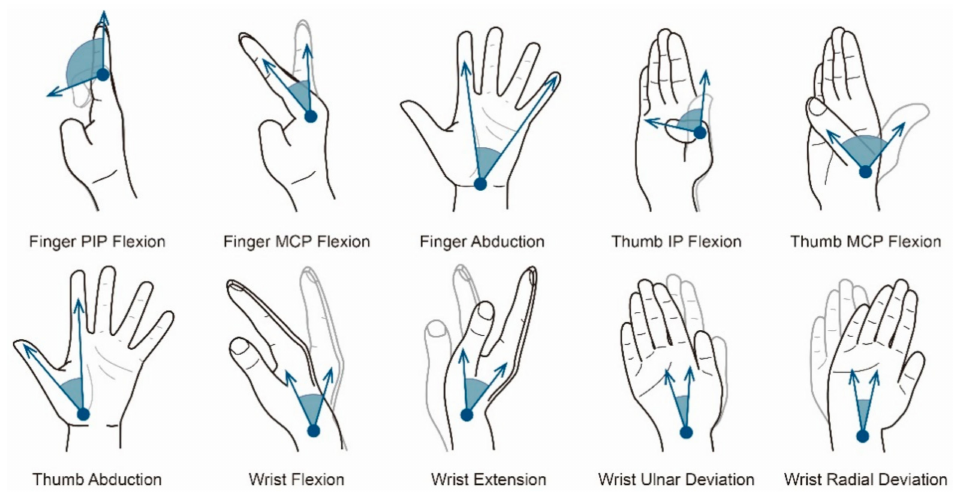
Figure 2. The motion forms of motion primitive